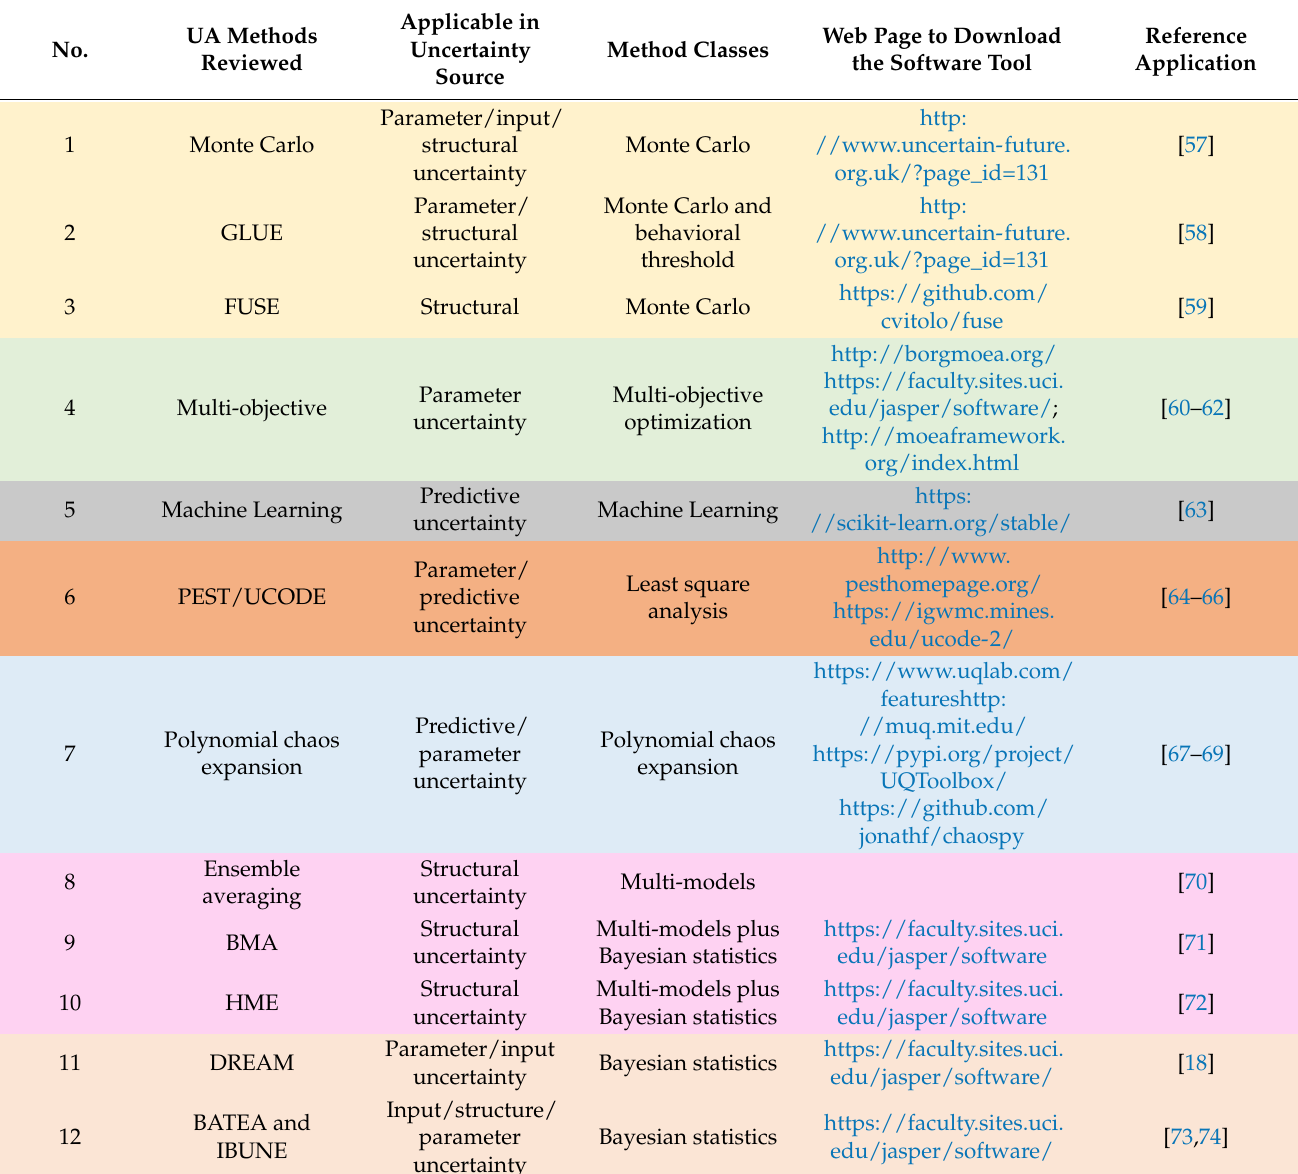
Table 1. Summary of uncertainty analysis methods, sources of uncertainty, and color coded broader methodological